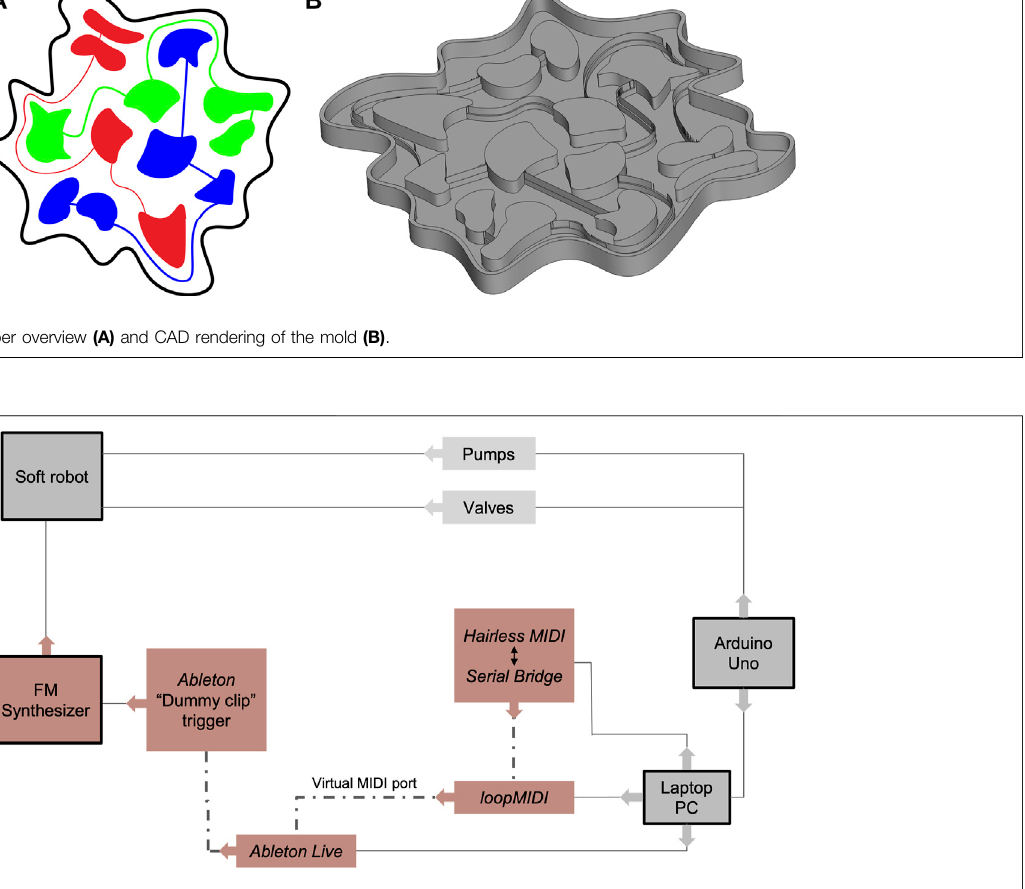
Frontiers in Robotics and AI |